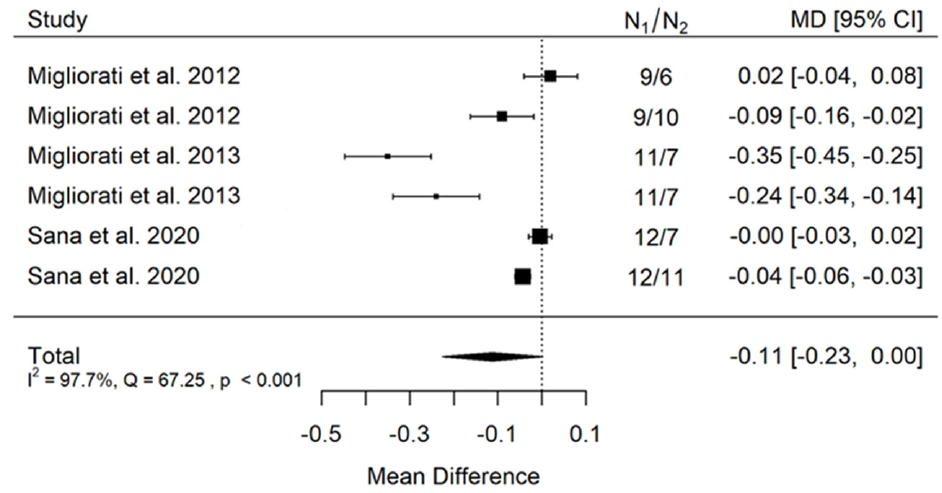
Figure 2. Forest plot for evalutaion of thread pitch dimension infulence on pull-out strentght in artifical bone model studies [33,34,41].